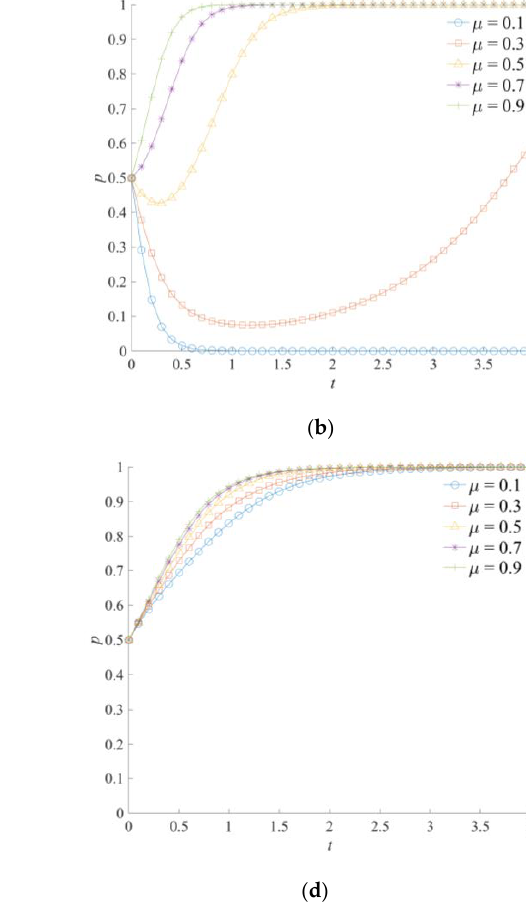
Figure 7. Evolution trajectory of the game system under different response coefficients of social emergency forces: ( a ) The influence of μ on the evolution of the game system; ( b ) the influence of μ on the evolution of the local government; ( c ) the influence of μ on the evolution of the neighboring government; ( d ) the influence of μ on the evolution of the central government.